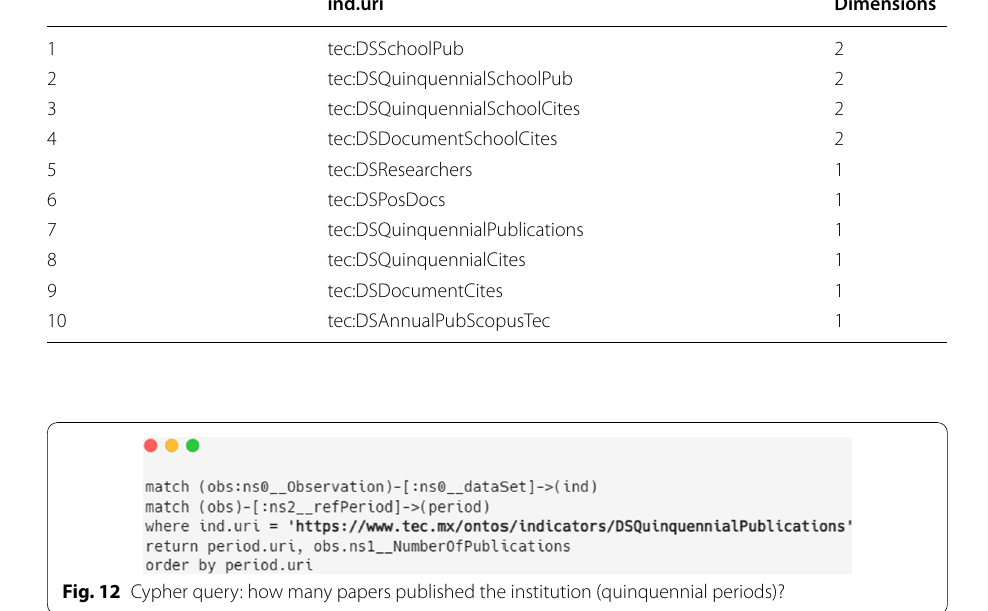
Table 5 Results for query: how many dimensions has every indicator? ind.uri Dimensions